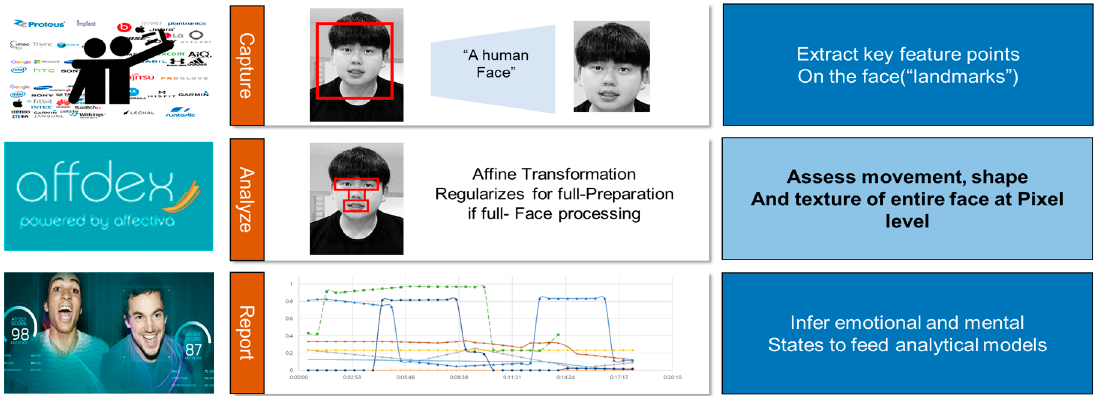
Figure 1. Facial recognition platform with respect to Affectiva [17]. * The figure included in this image is the author, who agreed to provide the figure.